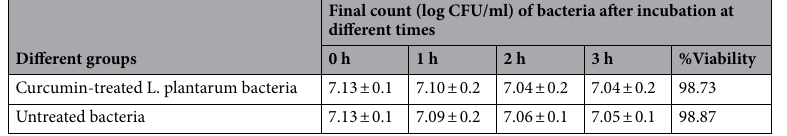
Different groups